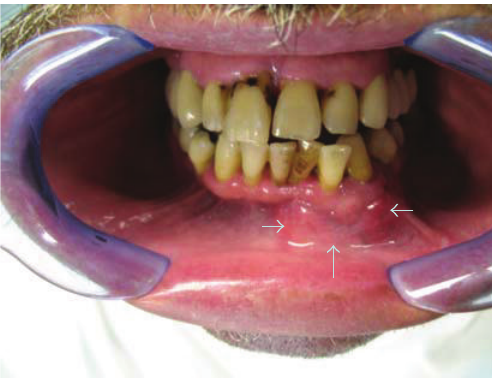
Figure 1: Case 1. Clinical presentation. Swelling of the mandible.